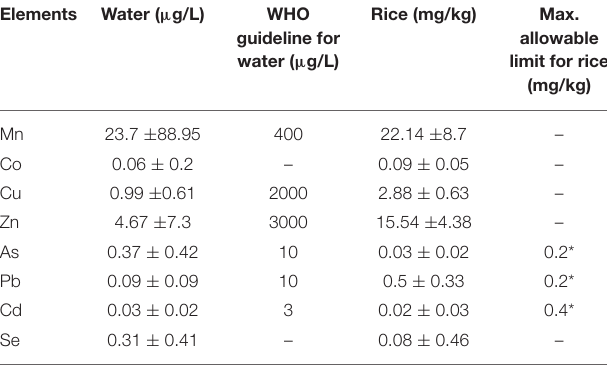
TABLE 1 | Groundwater and raw rice heavy metal(loid)s content comparison with safety